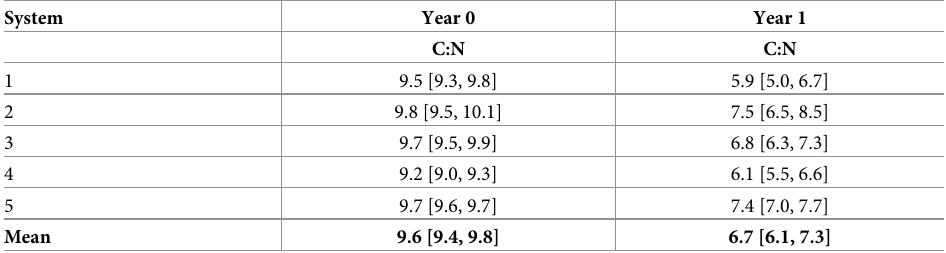
Table 3. Mean soil carbon:nitrogen ratios and 95% confidence limits prior to the start of the experiment and after the first year of intensive vegetable